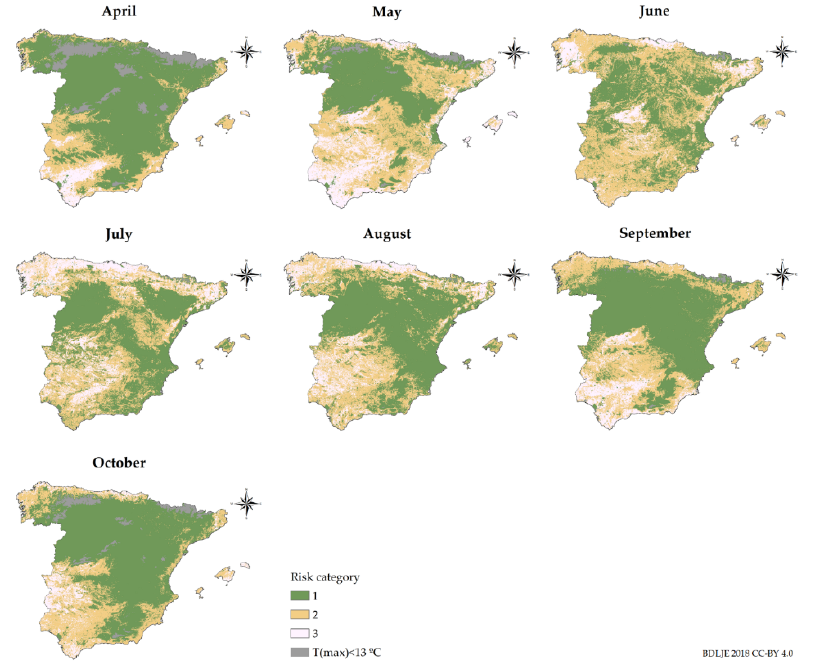
Figure 5. Monthly BTV transmission risk maps in Spain. There are represented three risk categories: low (1), medium (2) and high (3). These categories were defined for each monthly map according to the natural break classification criteria [96] in ArcMap TM . Gray areas show areas where the mean maximal temperature is less than 13 °C. Administrative boundaries provided by Instituto Geográfico Nacional (ign.es); BDDAE CC-BY 4.0.